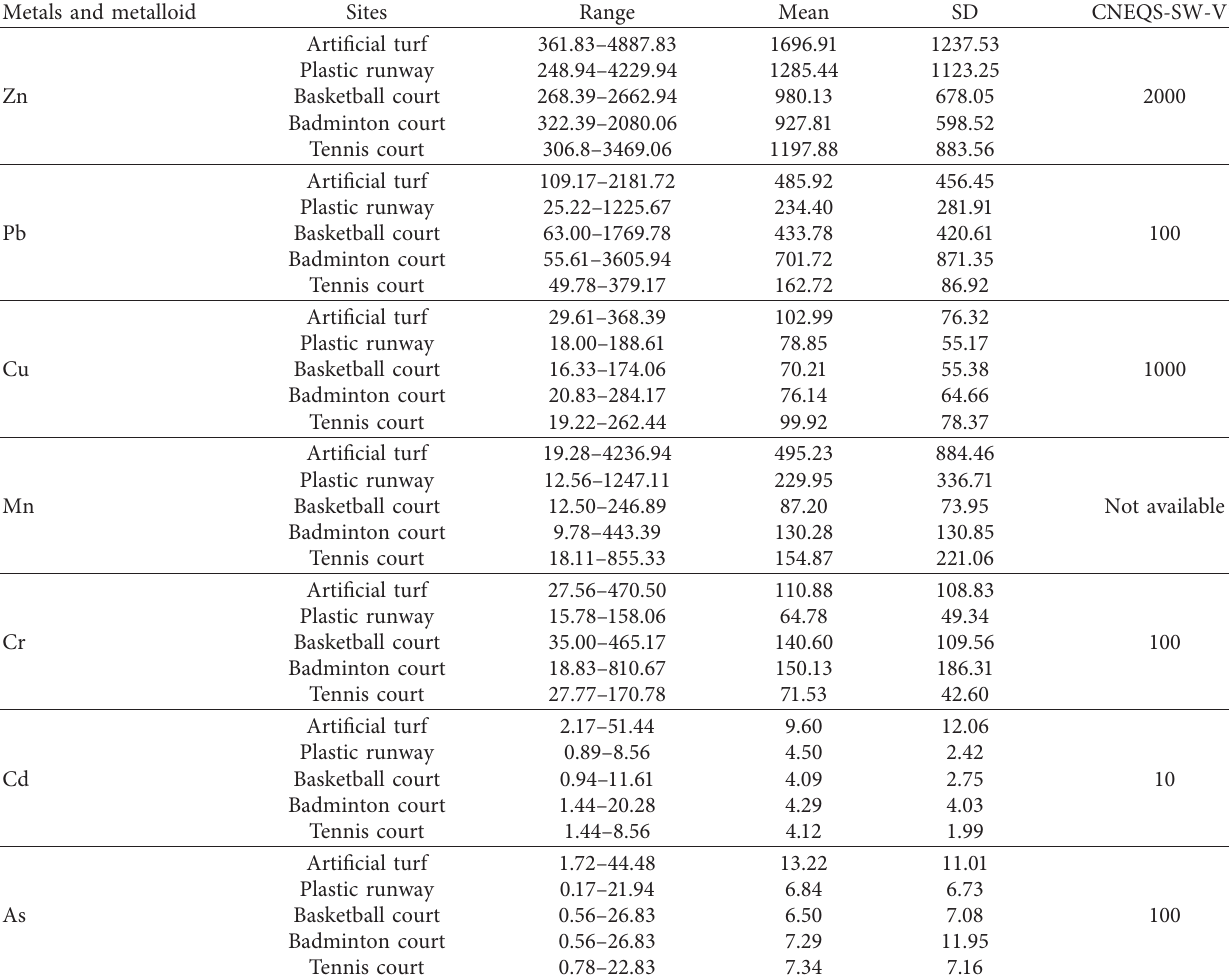
Table 3: Metalloid and metal (total) concentrations ( μ g/L) in runoff from different athletic fields. Metals and